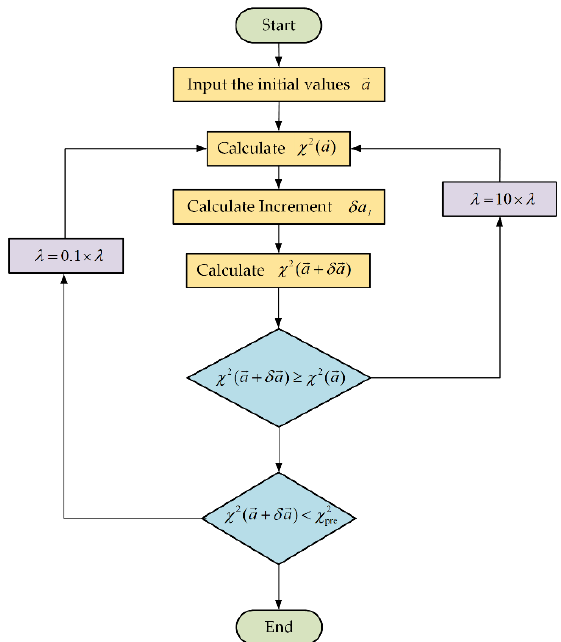
Figure 9. Flow chart of the Marquardt NLLS